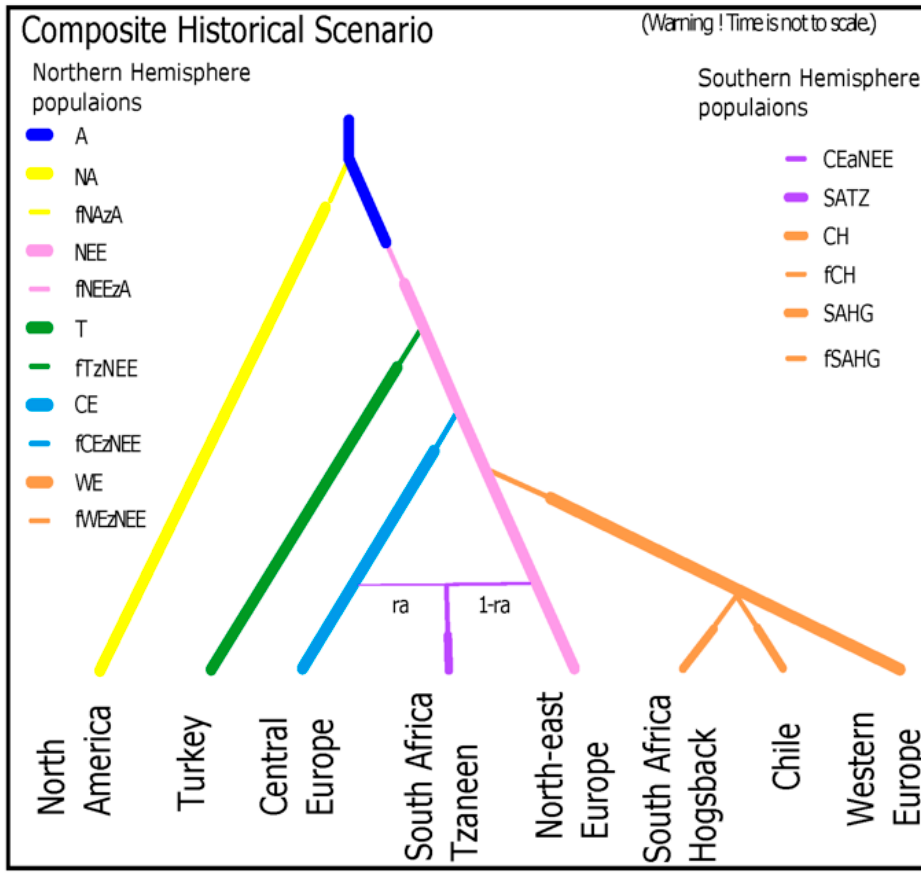
Figure 4. A graphical representation of the overall combined winning historical scenario showing relative timings of cluster and subcluster divergence and colonization events. Founder events and bottlenecks (f in legend) are indicated by thinner lines to indicate a reduction in effective population size. Ra is the rate of admixture and the thickness of lines that indicate the relative contribution from each population. A is the ancestral population, NA the North American cluster, NEE the Northeast European subcluster, T the Turkish subcluster, CE the Central European subcluster, WE the Western European cluster, SATZ the South Africa Tzaneen population group, SAHG the South Africa Hogsback population group, CH the Chile population group.